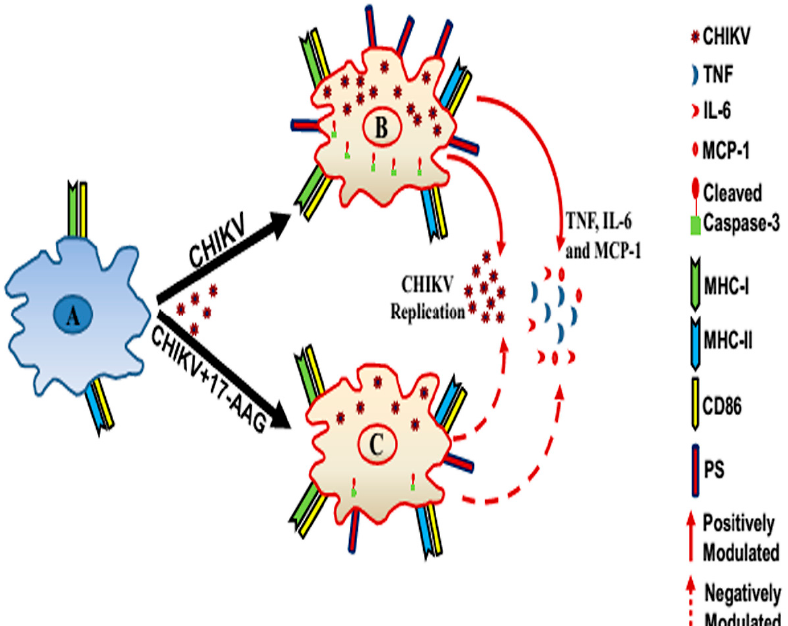
Figure 7. Proposed working model depicting CHIKV infection in macrophages and 17-AAG mediated possible regulation of its altered immune responses by inhibition of HSP90. Uninfected macrophage ( A ); and CHIKV infected macrophage ( B ) showing induction of MHC I/II, CD86 molecules as immune activation markers along with inflammatory cytokines/chemokine (TNF, IL-6 and MCP-1) production and apoptosis by phosphatidylserine (PS) and cleaved caspase-3 expression. ( C ) 17-AAG has been found to regulate the viral infection, apoptosis and inflammatory responses (TNF, IL-6 and MCP-1), suggesting its therapeutic implication in CHIKV infection.